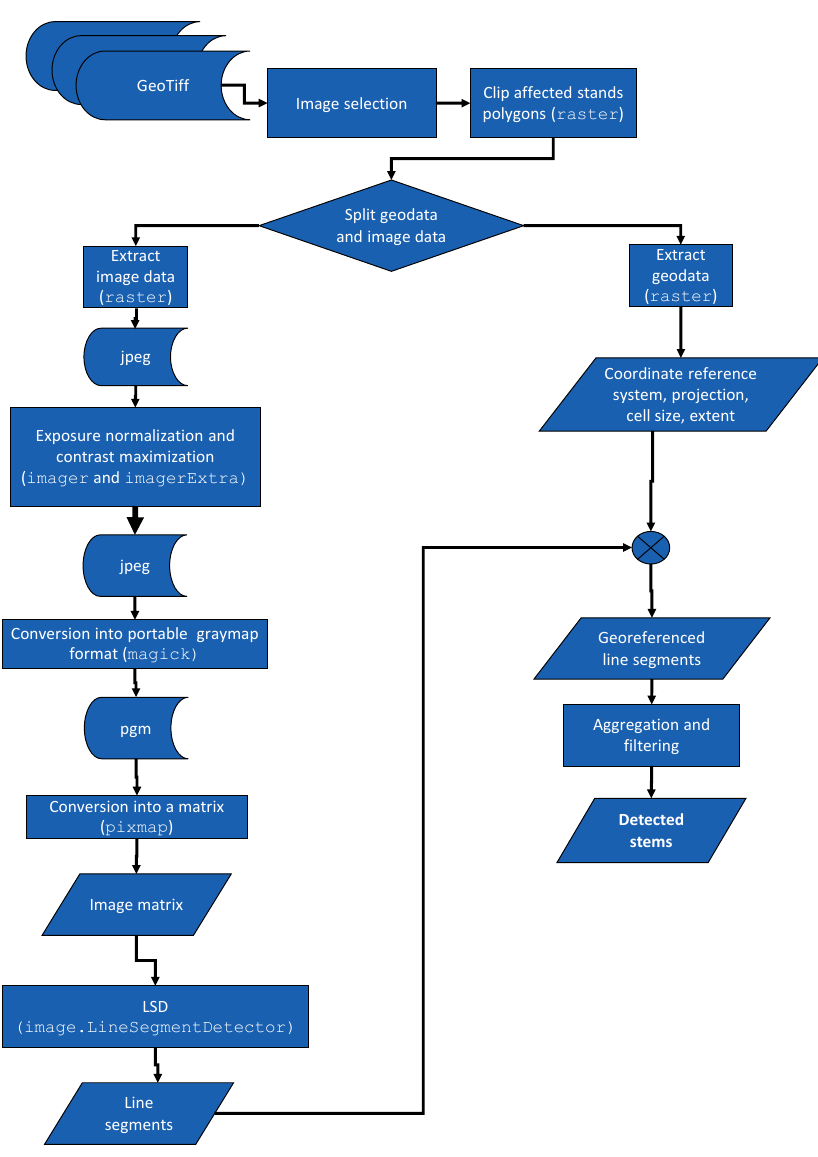
Figure 5. Workflow of the automatic stem detection.